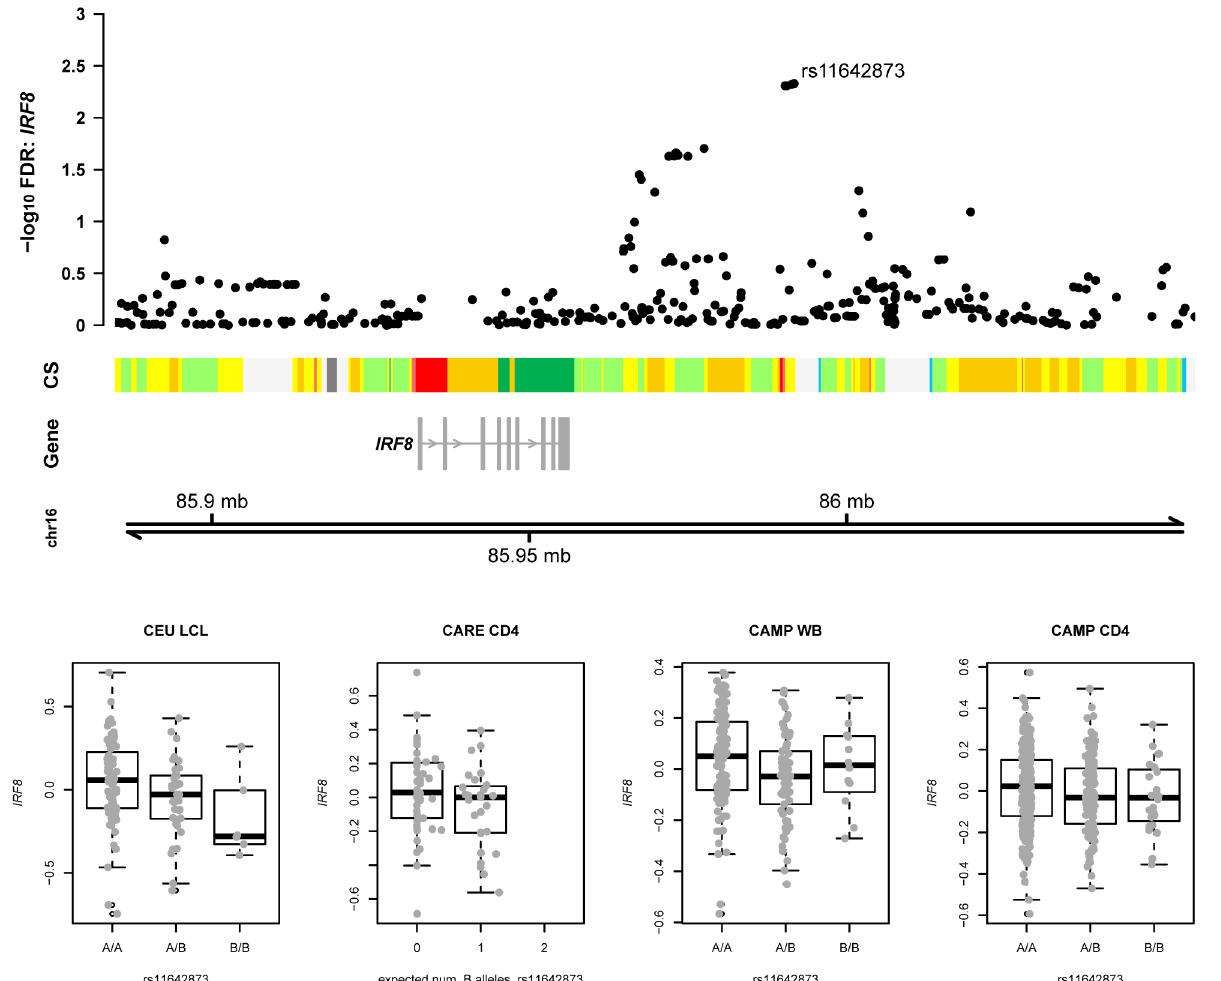
Fig 7. Evidence for an eQTL signal at the IRF8 locus associated with systemic sclerosis. Top panel: – log 10 FDR for meta-analysis associations of nearby SNPs with expression of the longer isoform of IRF8 . Middle panel: Chromatin states (CS) in LCLs (GM12878) [12] and the target IRF8 transcript. The two most strongly associated SNPs (including the systemic sclerosis GWAS [38] index SNP rs11642873) overlap a predicted weak enhancer region (yellow). Nearby upstream is a predicted active promoter region (red) that is likely spurious given that it overlaps no gene, predicted or otherwise. Bottom panel: boxplots showing probe expression residuals by genotype of index SNP rs11642873 in the four individual cohorts, where the “ A ” allele is A and the “ B ” allele is C. None of the cohort-specific associations are individually significant at FDR < 5%, though the meta-analysis is significant at this level.